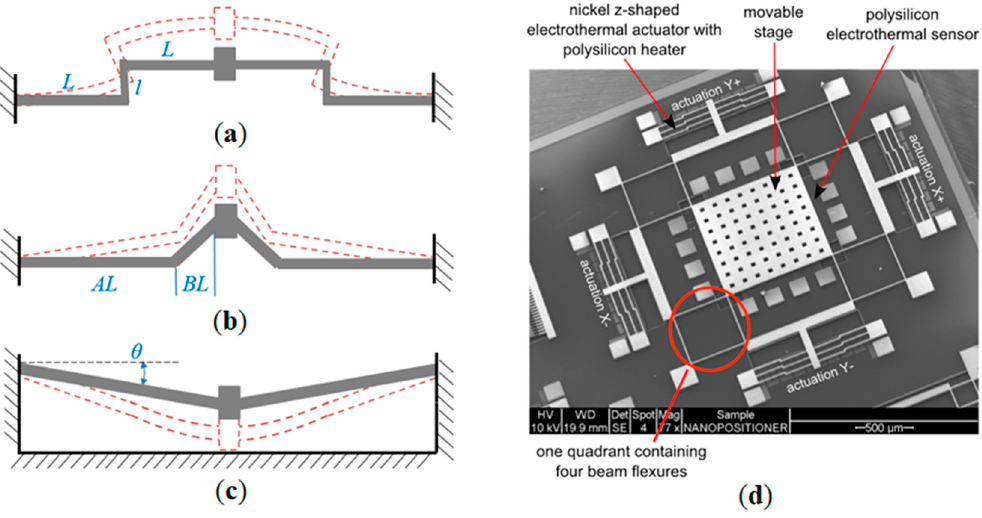
Figure 8. Alternative shapes of chevron actuators: ( a ) Z-shape chevron; ( b ) kink-shape chevron; ( c ) out-of-plane chevron; ( d ) application of the Z-shape actuator in a nanopositioner [94].